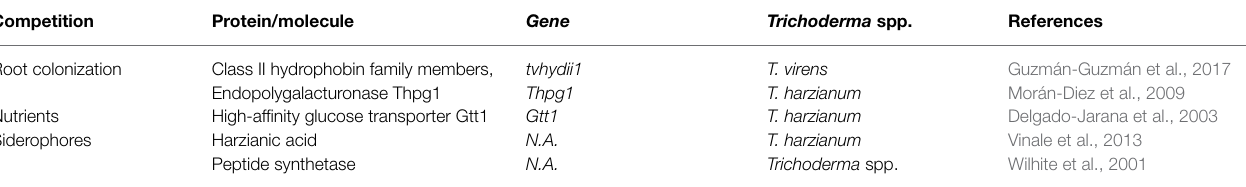
TABLE 4 | Role of Trichoderma spp. genes involved in competition for nutrients and root colonization against R.